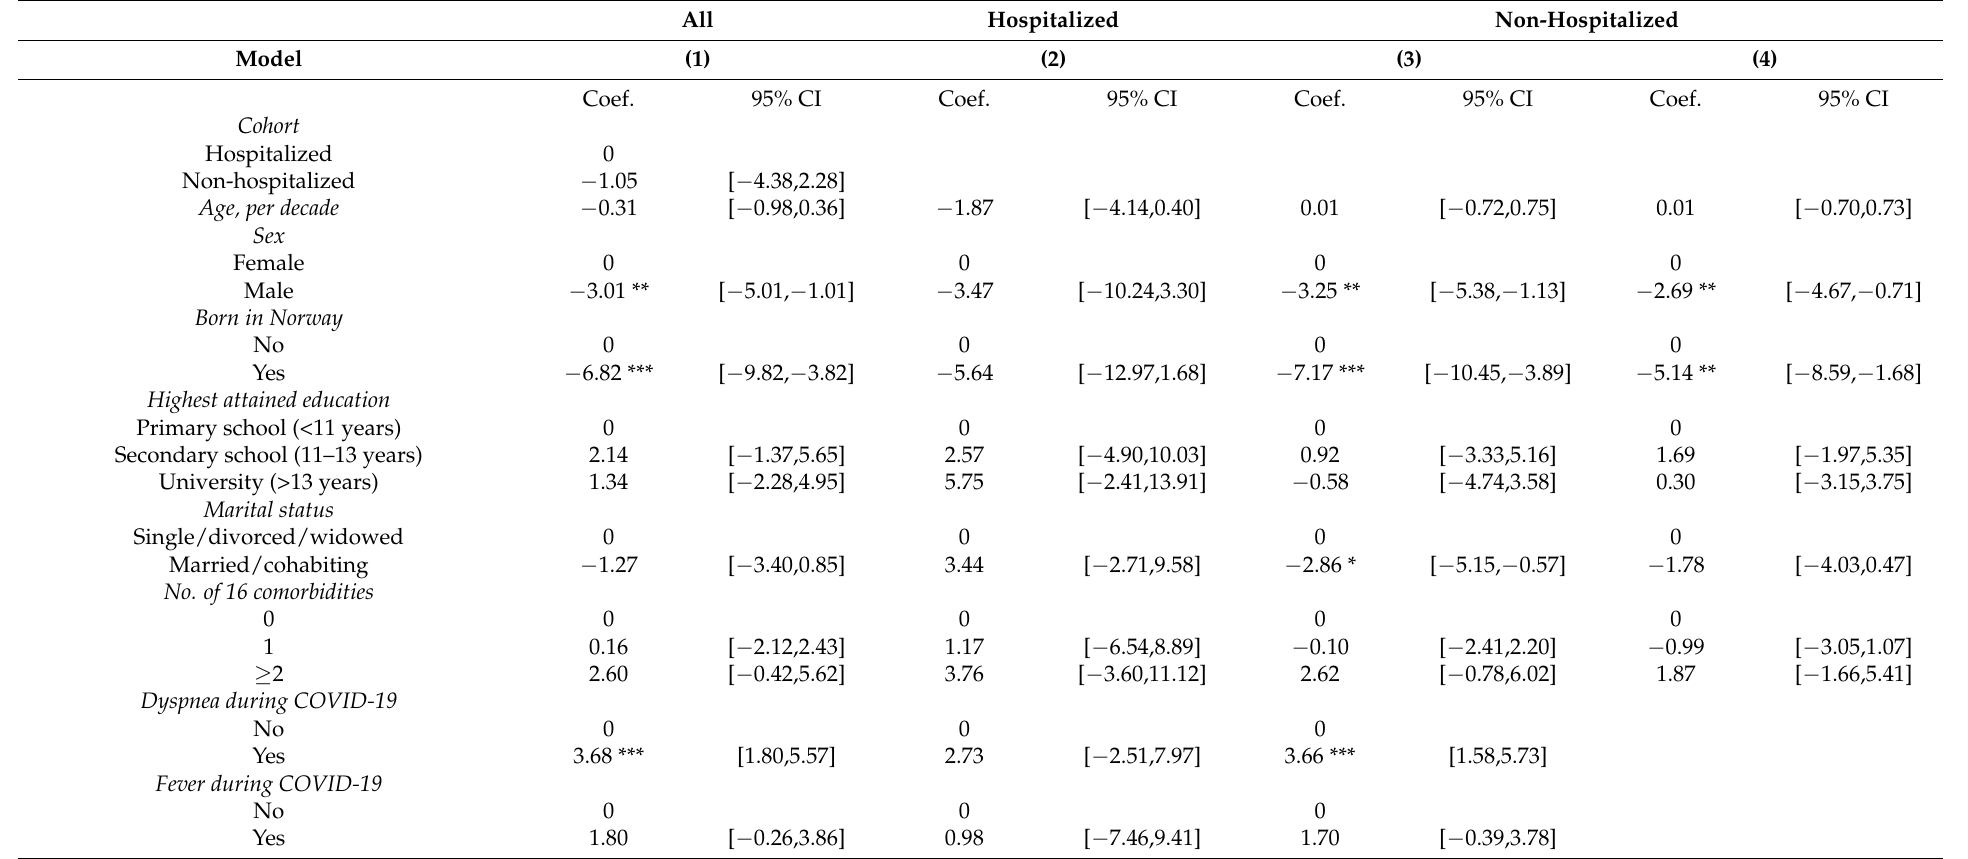
Table 3. Determinants of symptoms of post-traumatic stress (PCL-5 total scores). Unstandardized beta coefficients with bootstrapped 95% confidence intervals and p -values, in stratified analyses. Multivariable linear